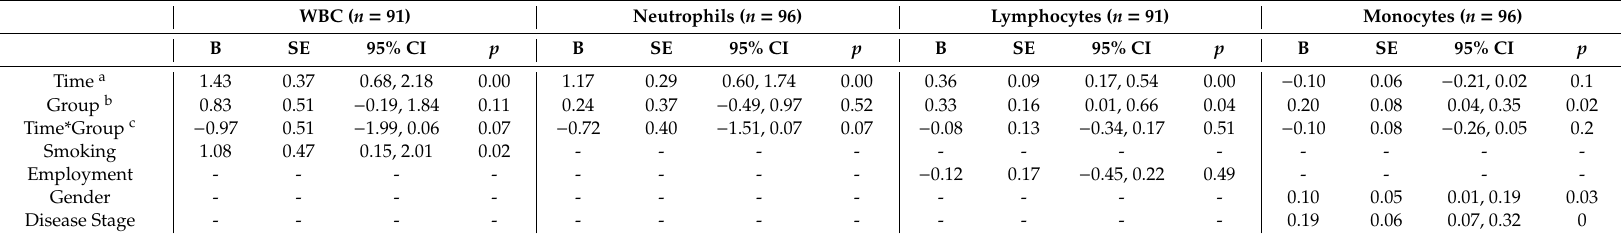
Table 4. LMM models for predicting WBC concentrations (K / uL).